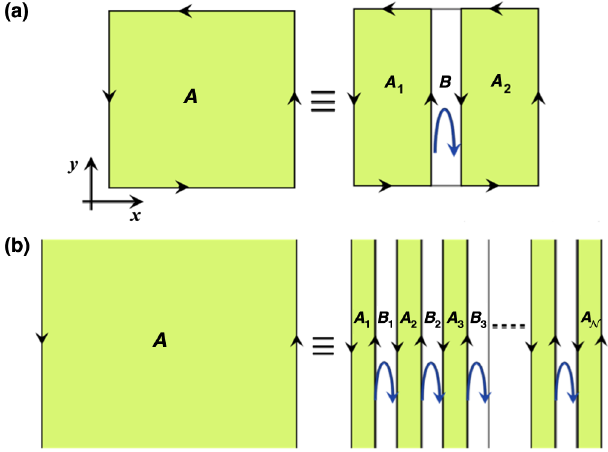
FIG. 2. An Abelian FQH state can be imagined as an array of coupled one-dimensional chains, each described by a free-boson CFT. (a) FQH region A can be split into regions A 1 and A 2 in addition to the extremely narrow vacuum region B . The bent blue arrow represents the backscattering process between the two counterpropagating gapless modes. (b) By repeating this pro- cedure, we can map a 2D FQH state into an array of narrow strips A 1 to A N that are coupled to one another through backscattering. Each narrow strip can be imagined as a 1D chain with a free- boson